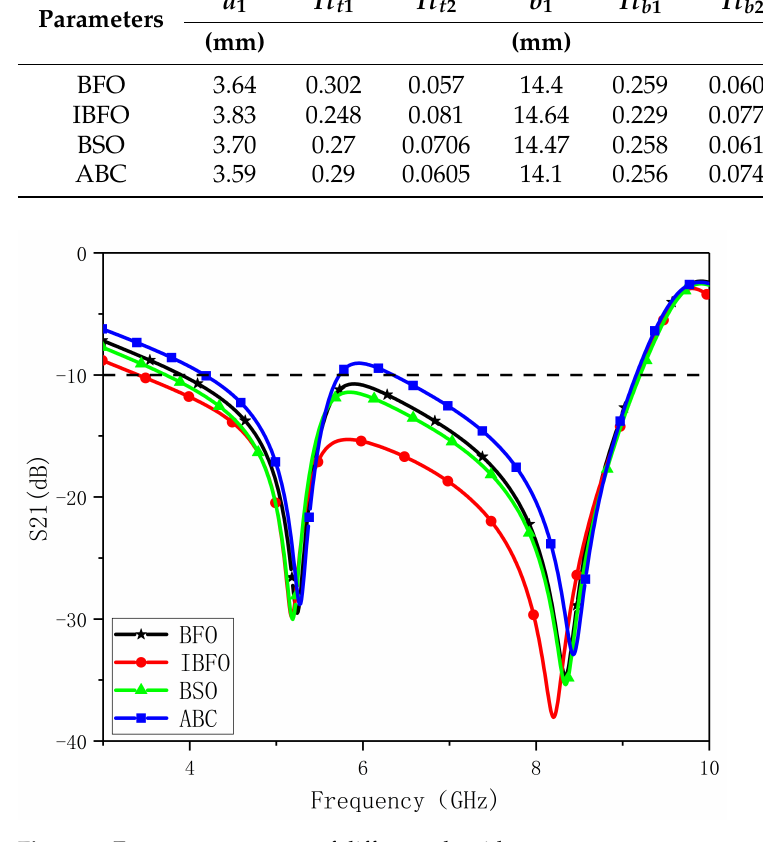
Figure 7. Frequency response of different algorithms.